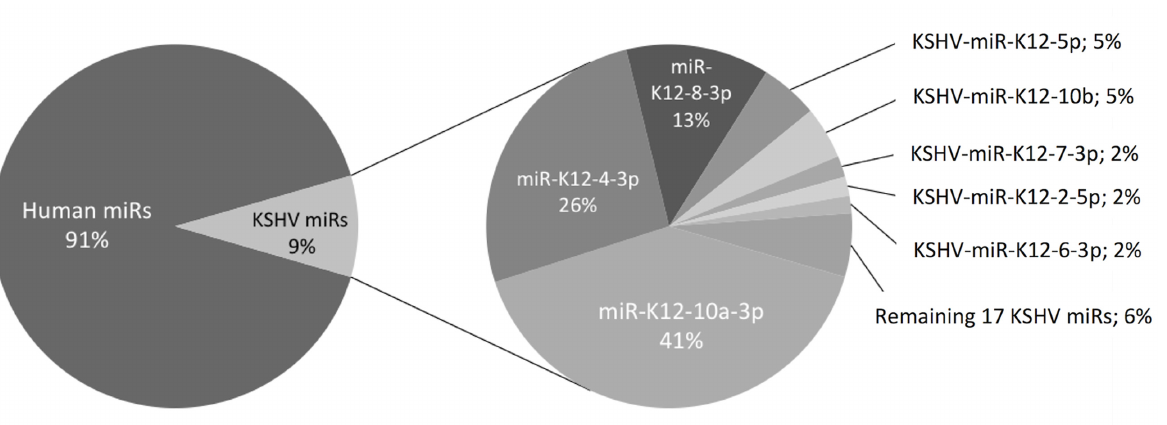
Fig 1. Relative abundance of human and KSHV-encoded miRNAs in KSHV-positive SLKK cells. The expression levels of KSHV miRNAs are shown as the percentage of the total of viral miRNA reads. Data are the mean of sequenced samples from three independent experiments, each with two technical replicates with opposite sequencing directions. Percentages have been rounded to the closest digit. For a detailed presentation, see S2 and S3 Tables.